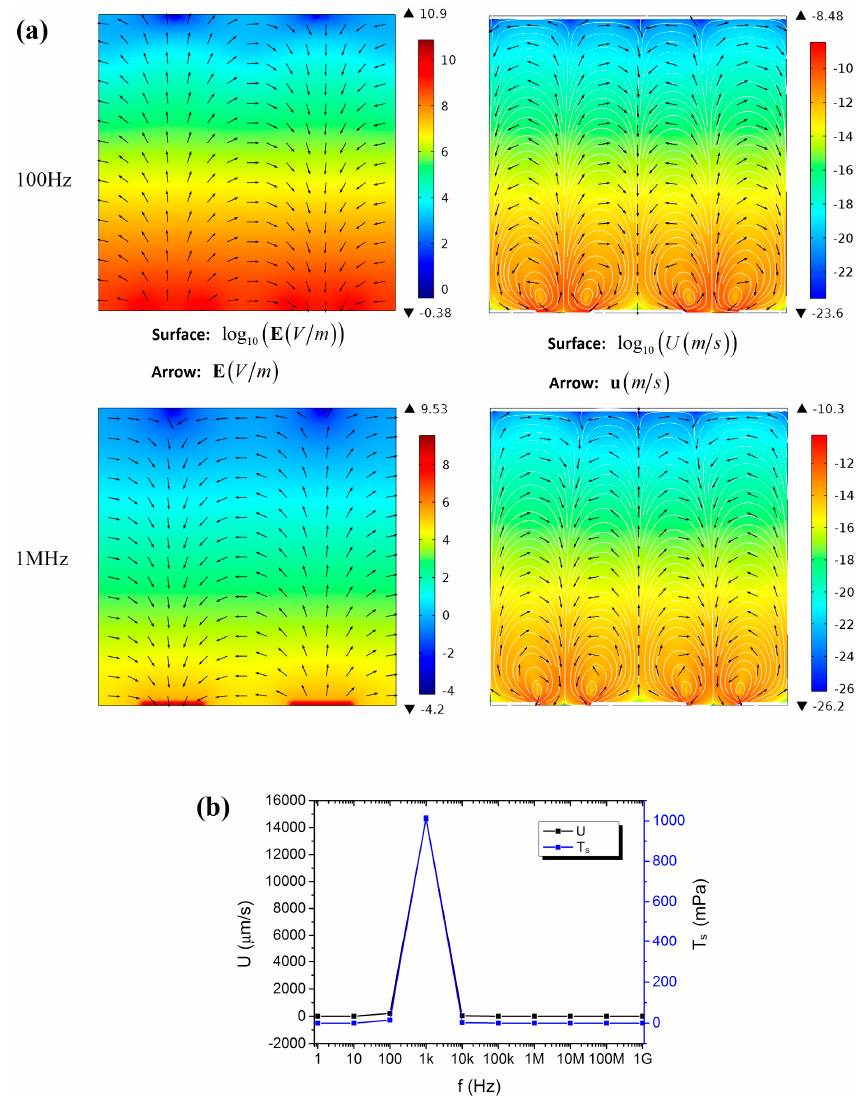
Figure 8. Simulation results of the 2D electrode system. ( a ) The electric field and the formed EOF in a vertical section at 100 Hz and 1 MHz, respectively. The surface plot used a logarithmic scale. ( b ) The frequency-dependent maximum value of the velocity amplitude ( U ) and the load (T s ) the lipid film experienced from the ACEO.